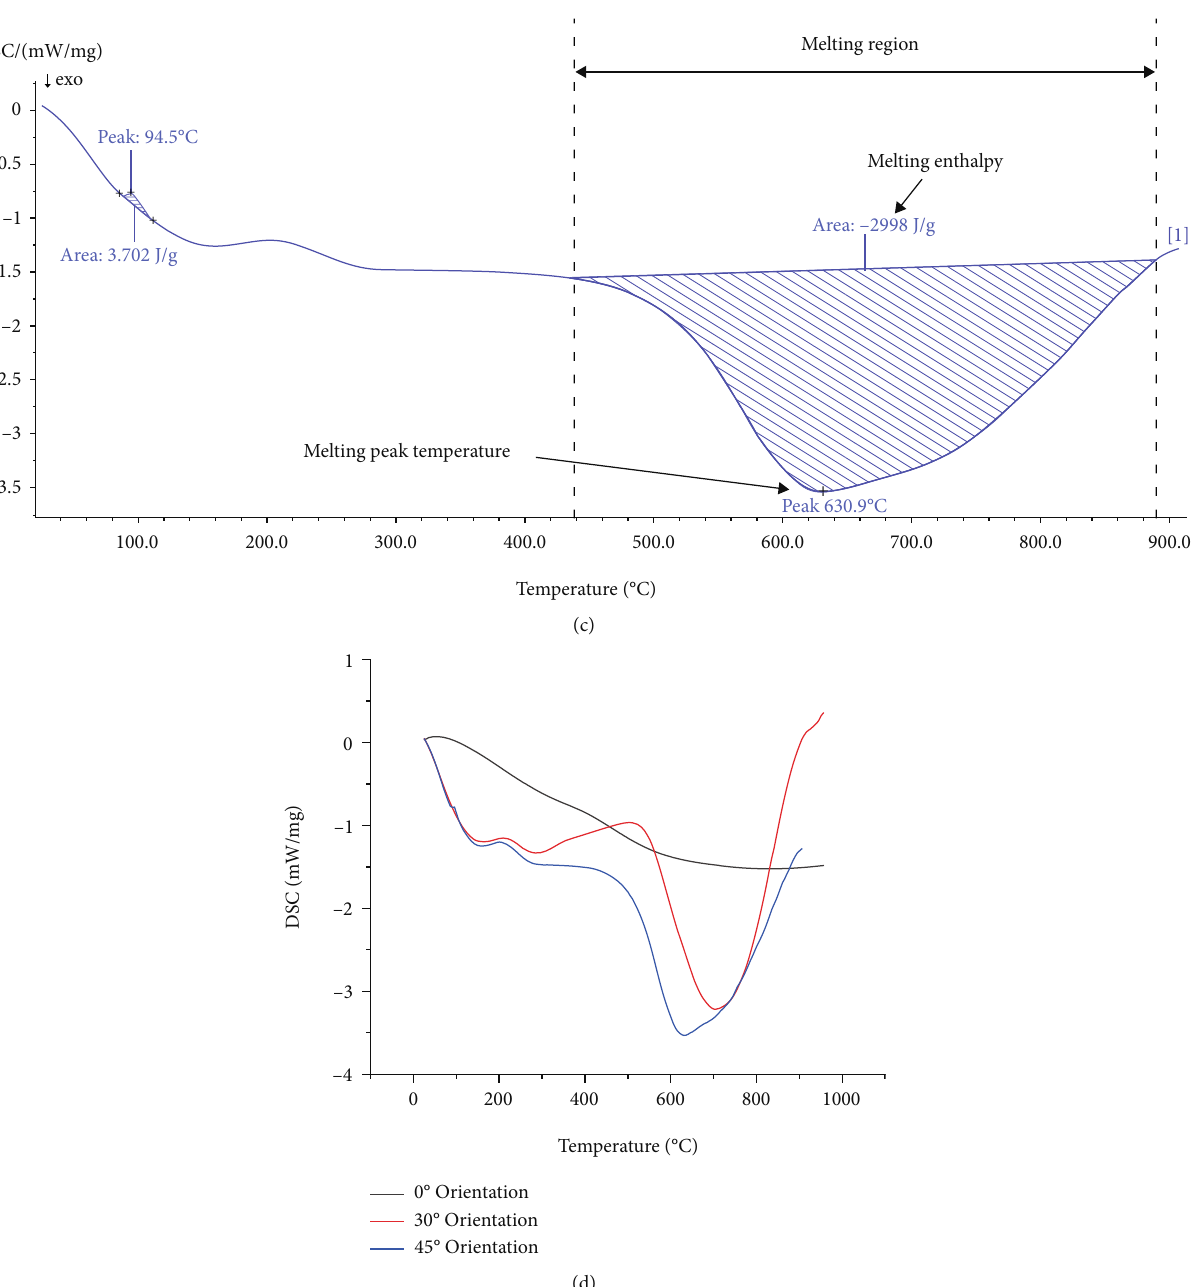
Figure 5: DSC plot for basalt fi ber – reinforced anamide composites (a) 0 ° orientation, (b) 30 ° orientation, (c) 45 ° orientation, and (d) comparison